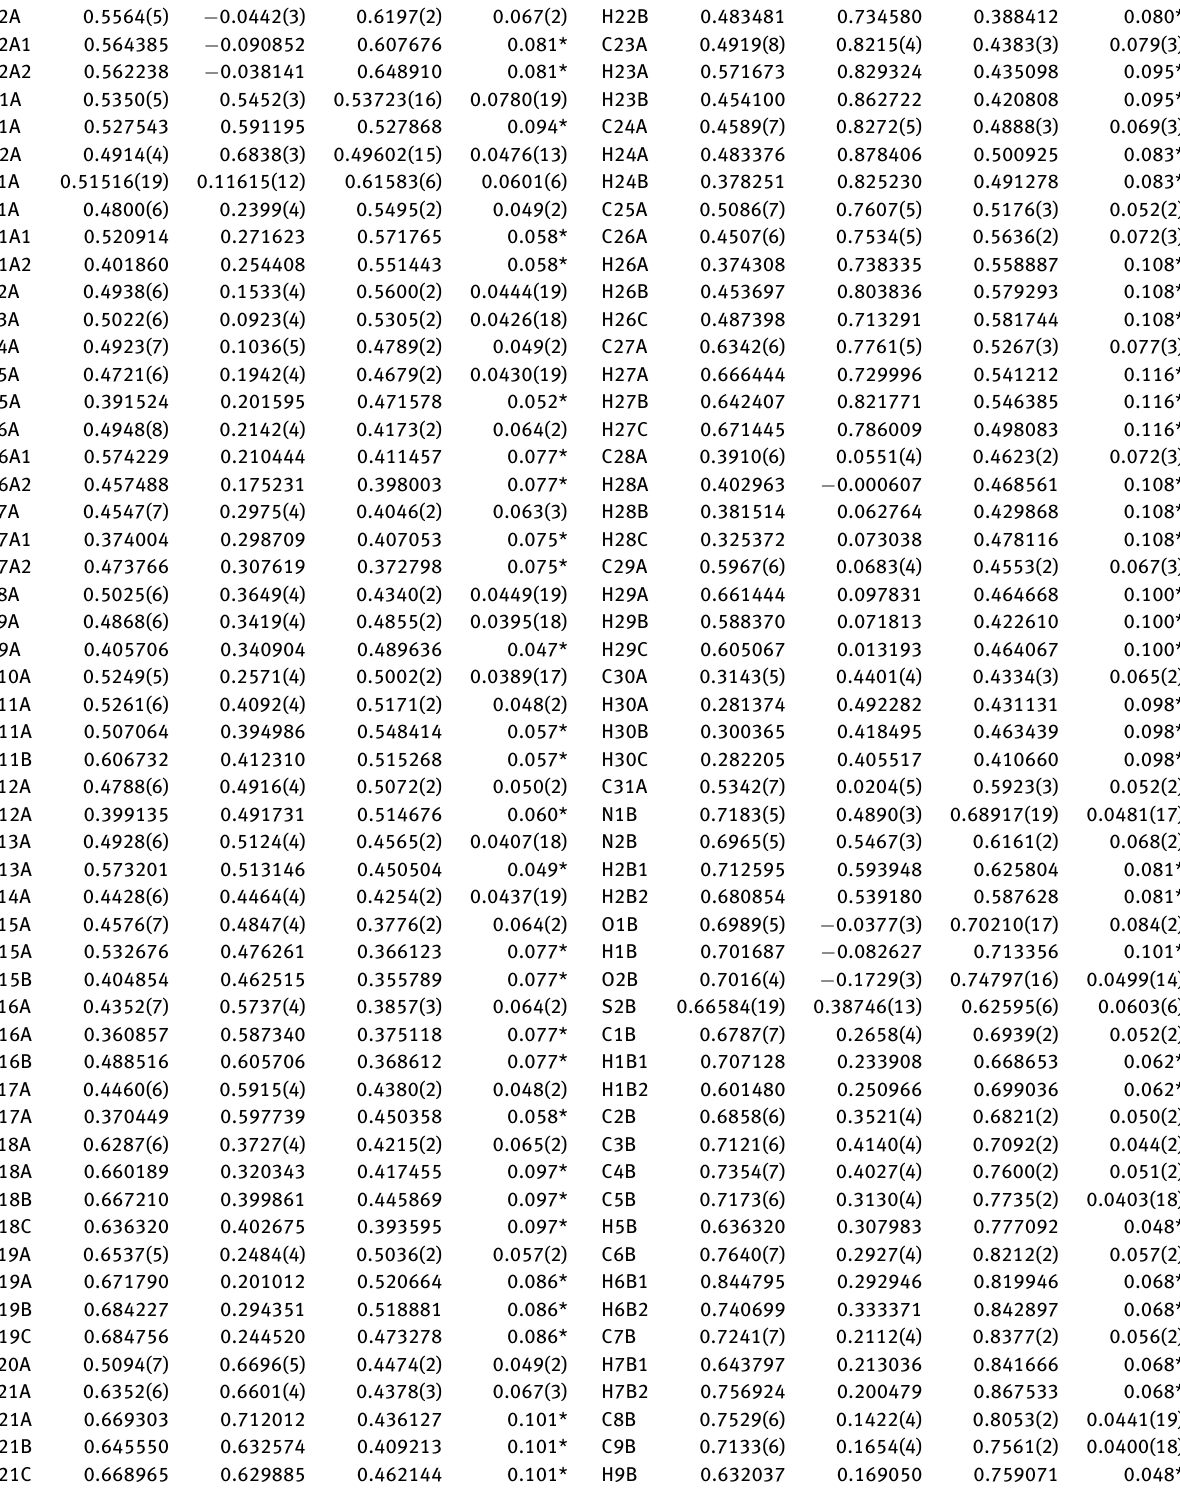
Table 2: Fractional atomic coordinates and isotropic or equivalent isotropic displacement parameters (Å 2